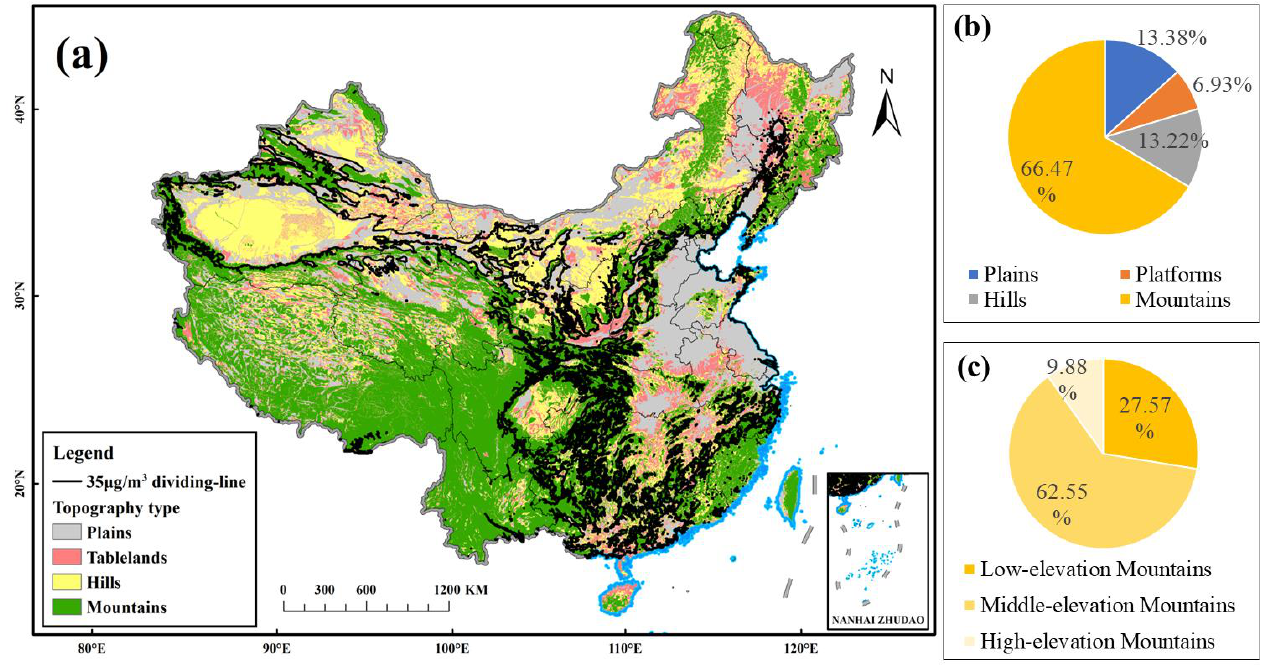
Figure 6. Superimposed distribution map of topography types and 35 μ g/m 3 dividing line ( a ), the length proportion of the 35 μ g/m 3 dividing line across the different topography types ( b ), the segmented length proportion across different elevation levels mountains in the mountains ( c ). Note: low elevation is altitude of less than 1000 m, middle elevation is altitude from 1000 to 3500 m, high elevation is altitude higher than 3500 m [60].